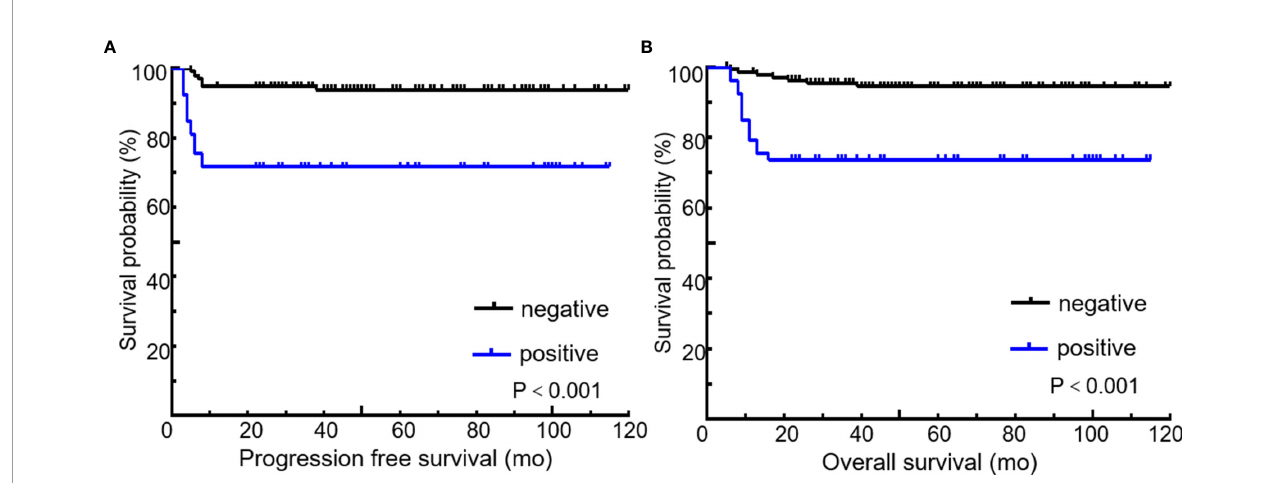
FIGURE 4 | Kaplan-Meier curves for PFS (A) and OS (B) according to end of treatment PET/CT results using the recommended cutoff value by the Deauville criteria. Deauville score of 1 to 3 means negative and 4 to 5 means positive.